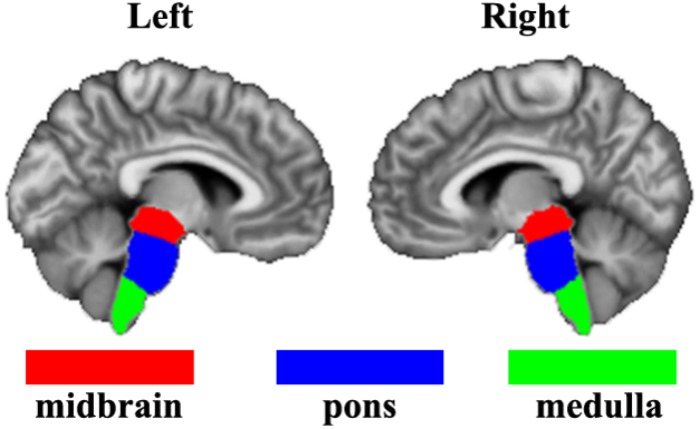
The definition of brainstem subregions based on a recent brainstem atlas which was constructed using Bayesian segmentation approach in MRI. Three subregions including midbrain, pons, and medulla were used in the present study.